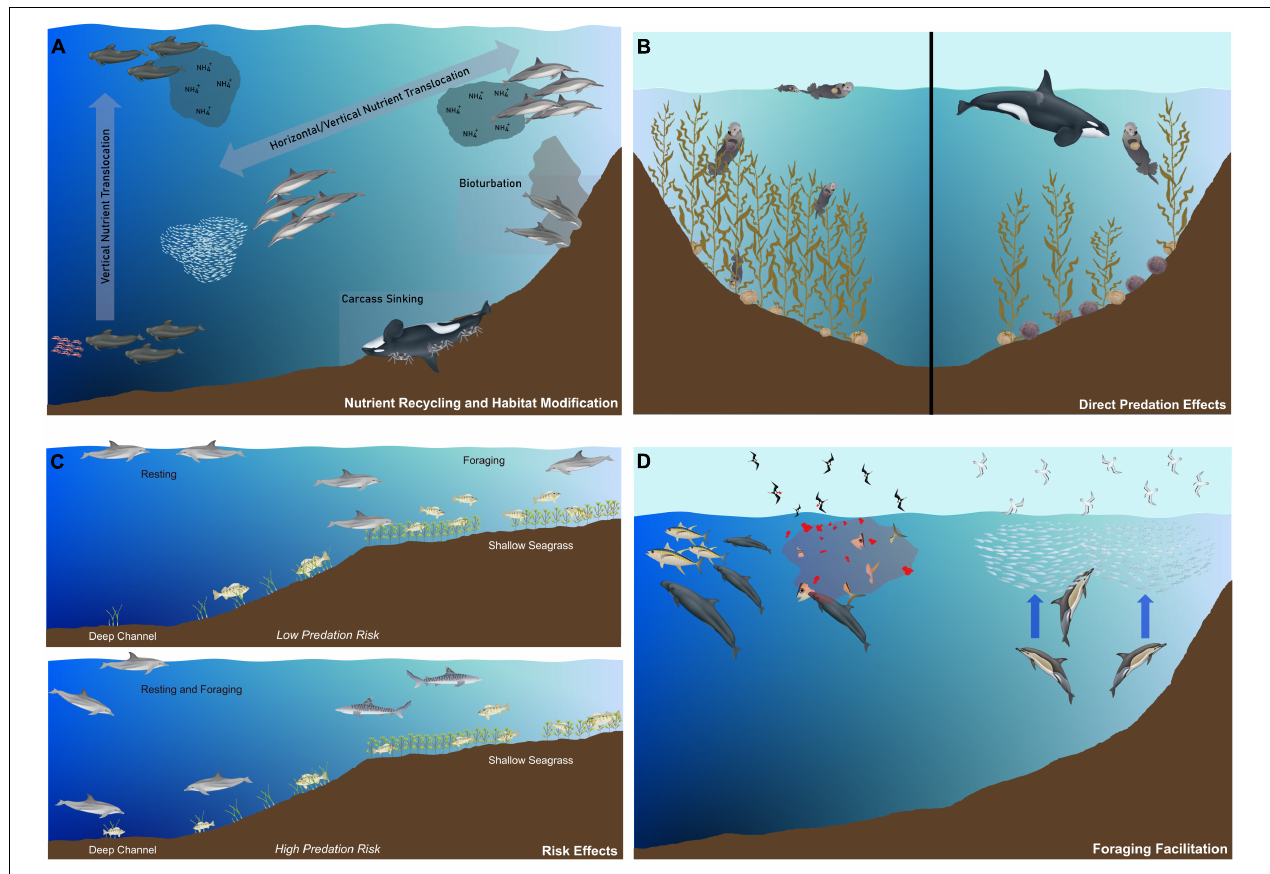
FIGURE 1 | Conceptual model of the ecological roles of small cetaceans in aquatic food webs (primarily marine). (A) Small cetaceans can mediate the translocation of limiting nutrients vertically (e.g., foraging on mesopelagic prey and sinking carcasses), horizontally (e.g., offshore foraging and resting/avoiding predators during the day in coastal waters), and through bioturbation. (B) Small cetaceans can mediate the consumptive effects of other predators in the ecosystem (e.g., killer whale, sea otter, sea urchin, kelp forests; Estes et al., 1998). (C) Small cetaceans may alter their foraging behavior and habitat utilization in response to the presence of predators (e.g., Shark Bay, Australia; Heithaus and Dill, 2002). (D) Small cetaceans influence the prey availability for other organisms in the ecosystem (e.g., Parkinson’s petrels feeding on prey scraps (left; Pitman and Ballance, 1992) and small fishes forced closer to the surface by the fear of predation by small cetaceans, making the fishes available for seabird predation